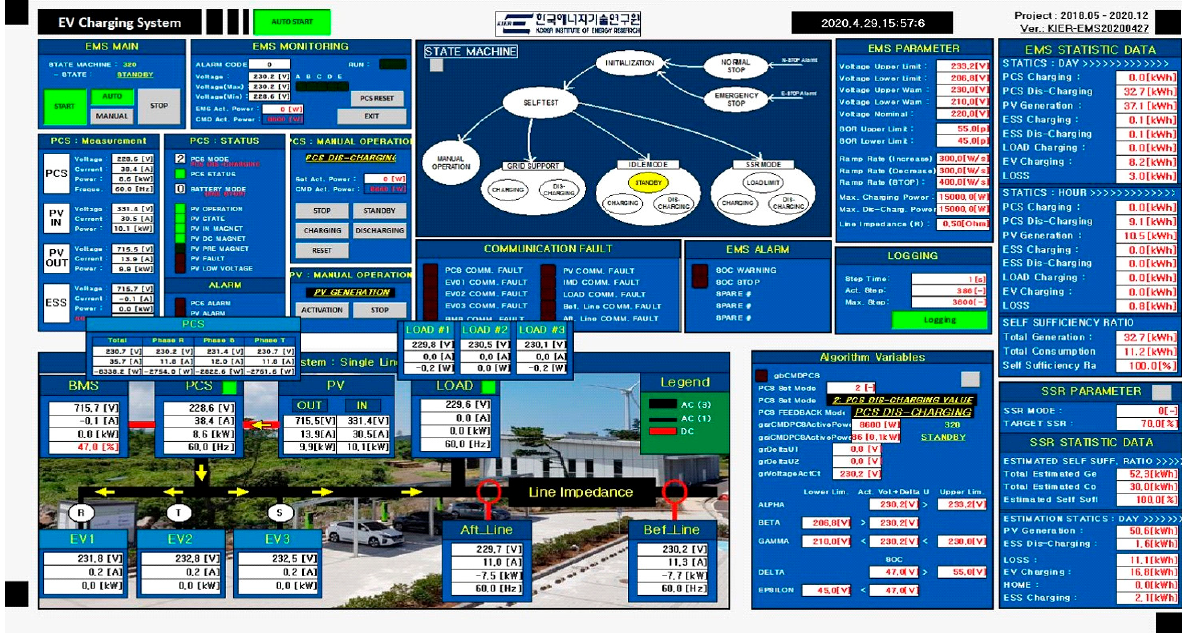
Figure 8. EMS for EV Charging Infrastructure.